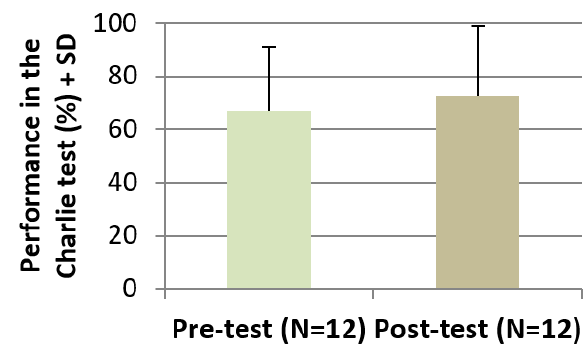
Figure 12: Pre- and post-assessment sessions of 12 children.